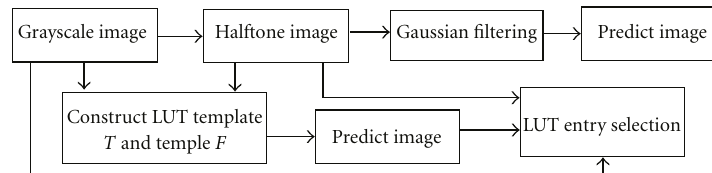
Figure 7: The flowchart of LUT entry